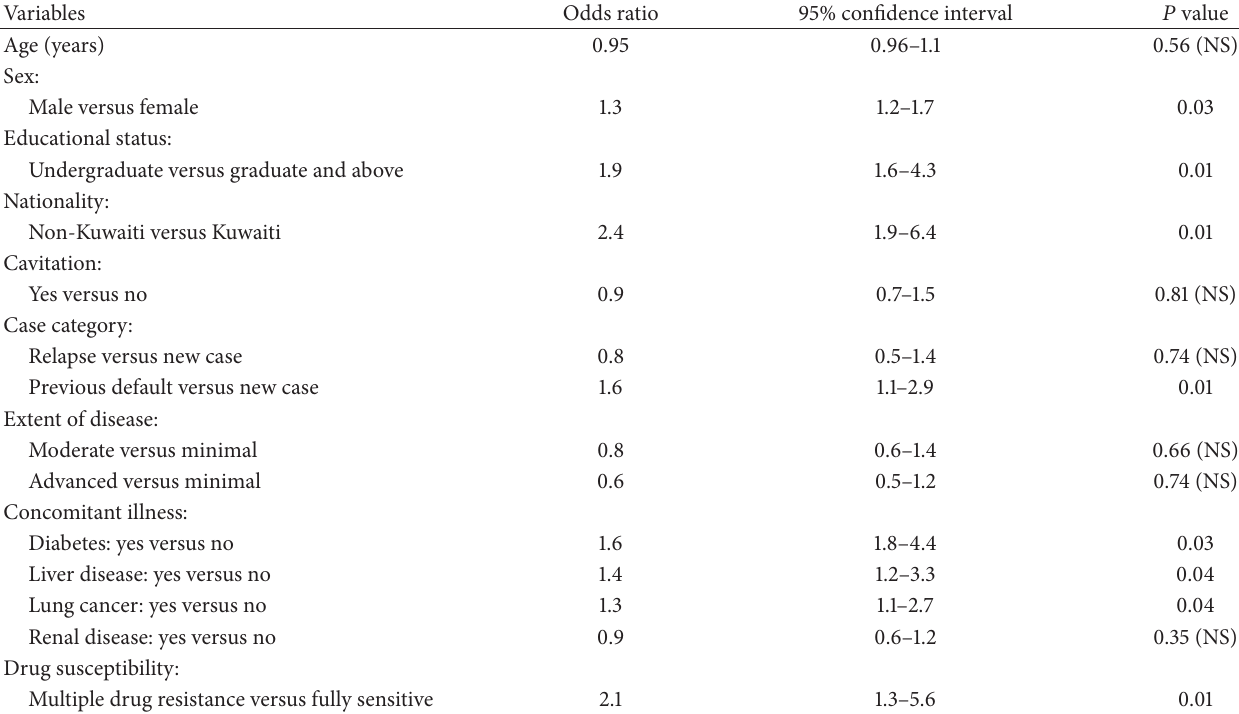
Table 5: Odds ratios from multiple logistic regression analysis, examining the association between selected risk factors and treatment